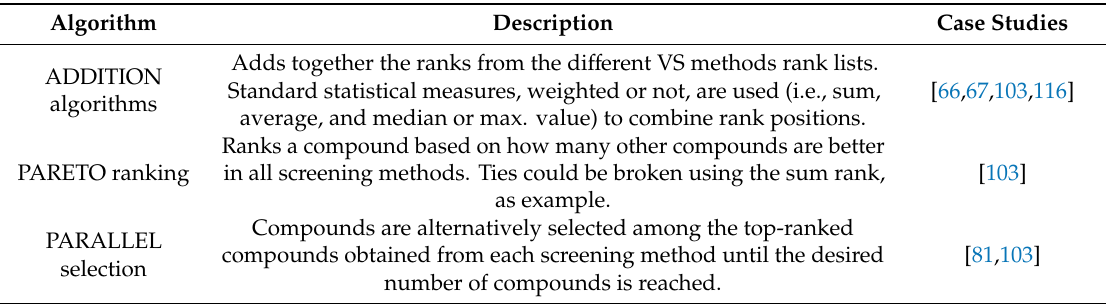
Table 1. Description of selected fusion algorithms implemented in parallel ligand-based (LB) and structure-based (SB) strategies. VS: virtual screening.